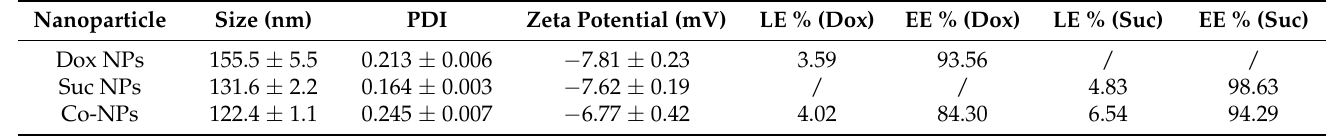
Table 1. Critical characteristics of nanoparticles.